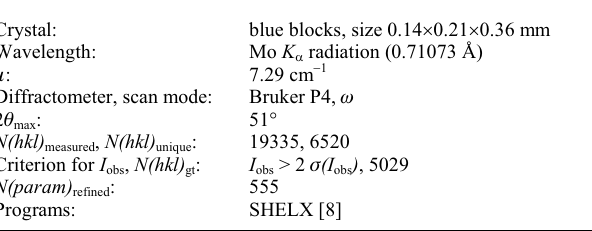
Table 1. Data collection and handling.